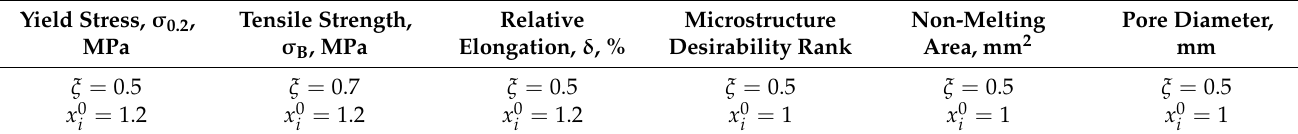
Table 1. Constants for conducting gray relational